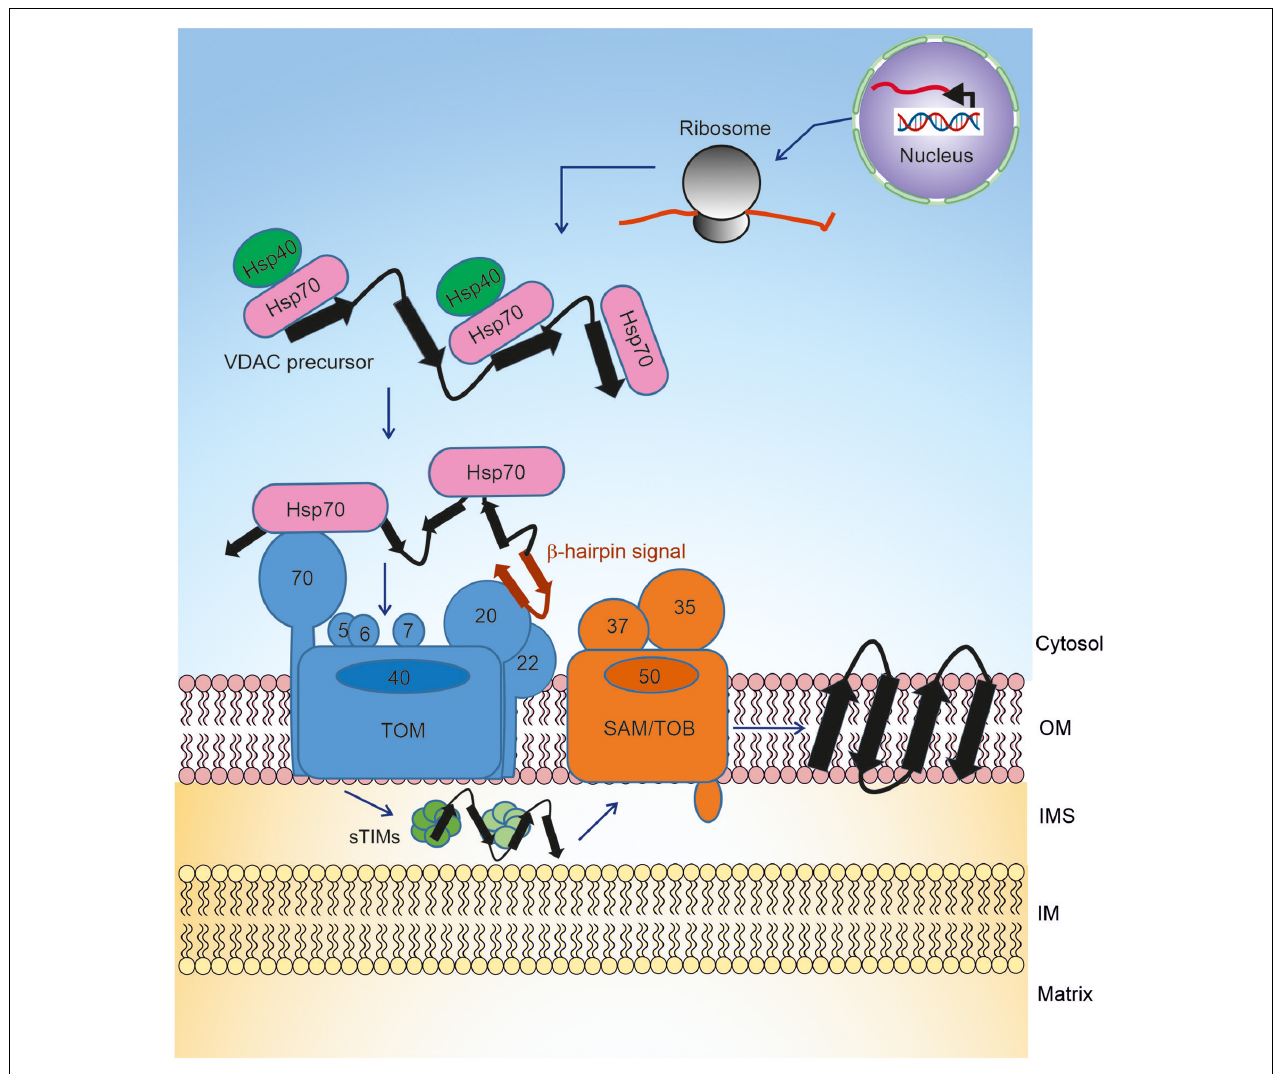
FIGURE 1 | Biogenesis pathway of VDAC. Precursors of VDAC are transcribed in the nucleus, translated on cytosolic ribosomes, and then transported to the mitochondrial surface with the help of chaperones. At the outer membrane, the precursors are initially recognized by receptors of the TOM complex and then translocated across the membrane via the pore formed by Tom40. In the IMS, the small TIM chaperones relay the newly synthesized VDAC molecule to the TOB/SAM complex, which facilitates the final steps of membrane integration.